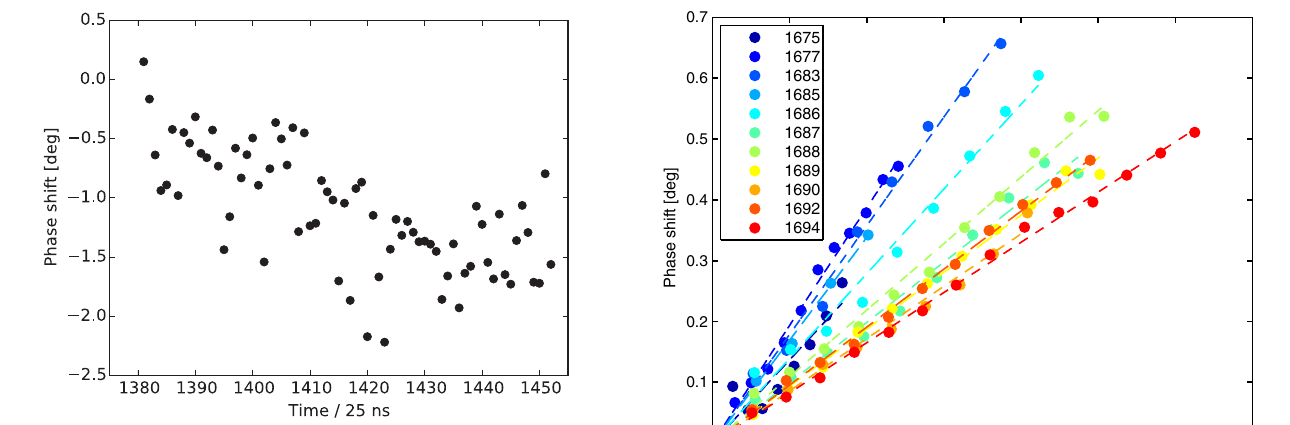
FIG. 3. Example of raw data for the phase shift along a bunch ¯ N ∼ 1 train of 72 bunches with . 1 × 10 11 averaged over 73 acquisitions spaced by 5 turns. Measurements were taken on FIG. 4. Average phase shift at bunch train injections in the LHC Beam 1 at injection energy at the beginning of the 2012 scrubbing as a function of the total beam intensity in Beam 1 for the 50 ns run with 25 ns spaced bunches (Fill 3389, 6-12-2012). beams during the scrubbing run in April 2011. The decrease in the slope of the curves between the first and the last fills is a sign of surface scrubbing. Each color corresponds to a different LHC fill. N ∼ 1 . 2 × 10 11 .